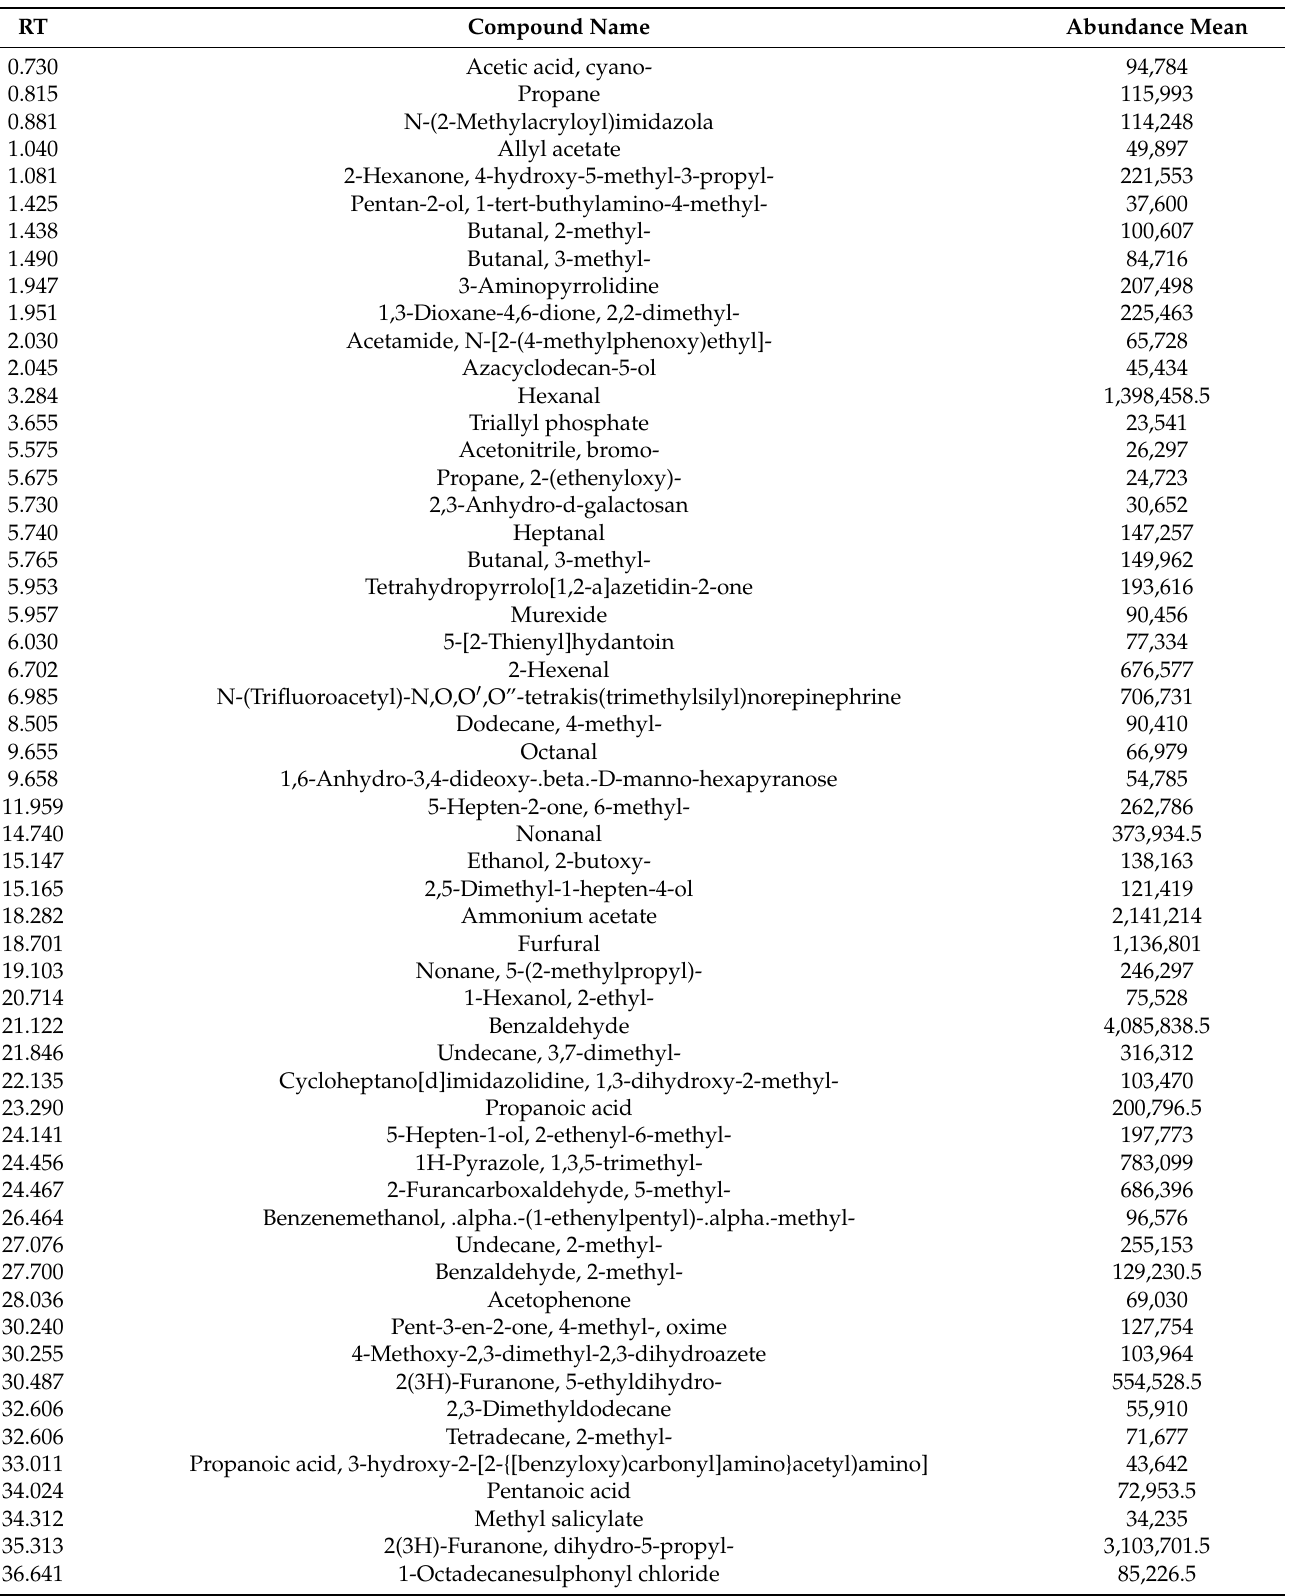
Table A5. Results for the TBV sample fingerprint determination with indication of the retention time (RT) and abundance mean for every identified